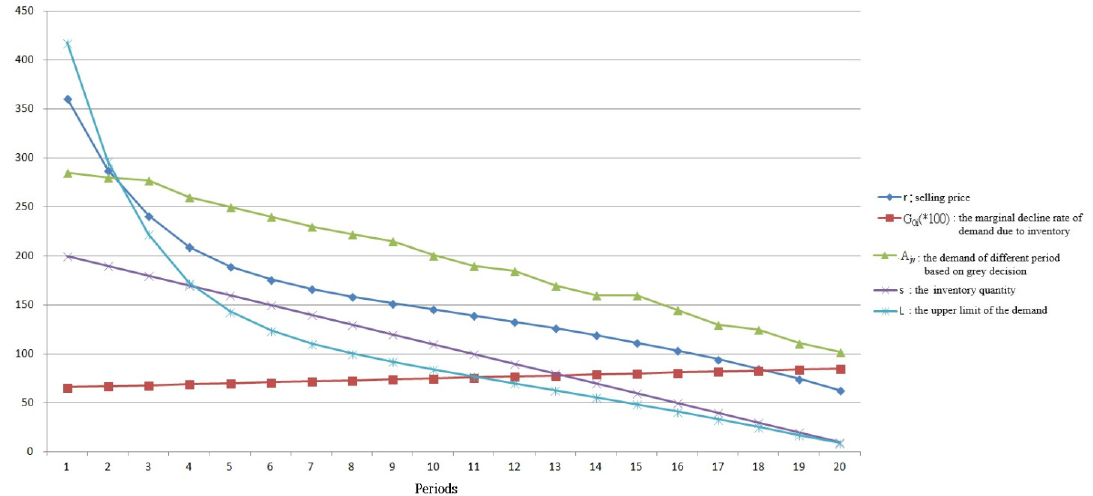
Figure 5. Upper limit of the demand ( L ) and related parameters of relationship.